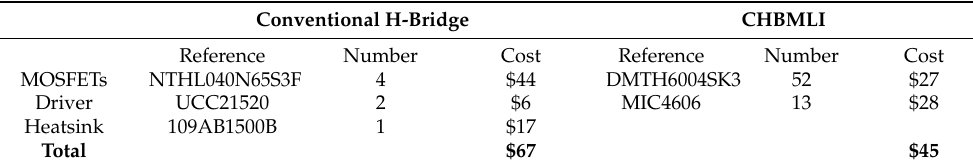
Table 10. MOSFETs + Driver + Heatsink.